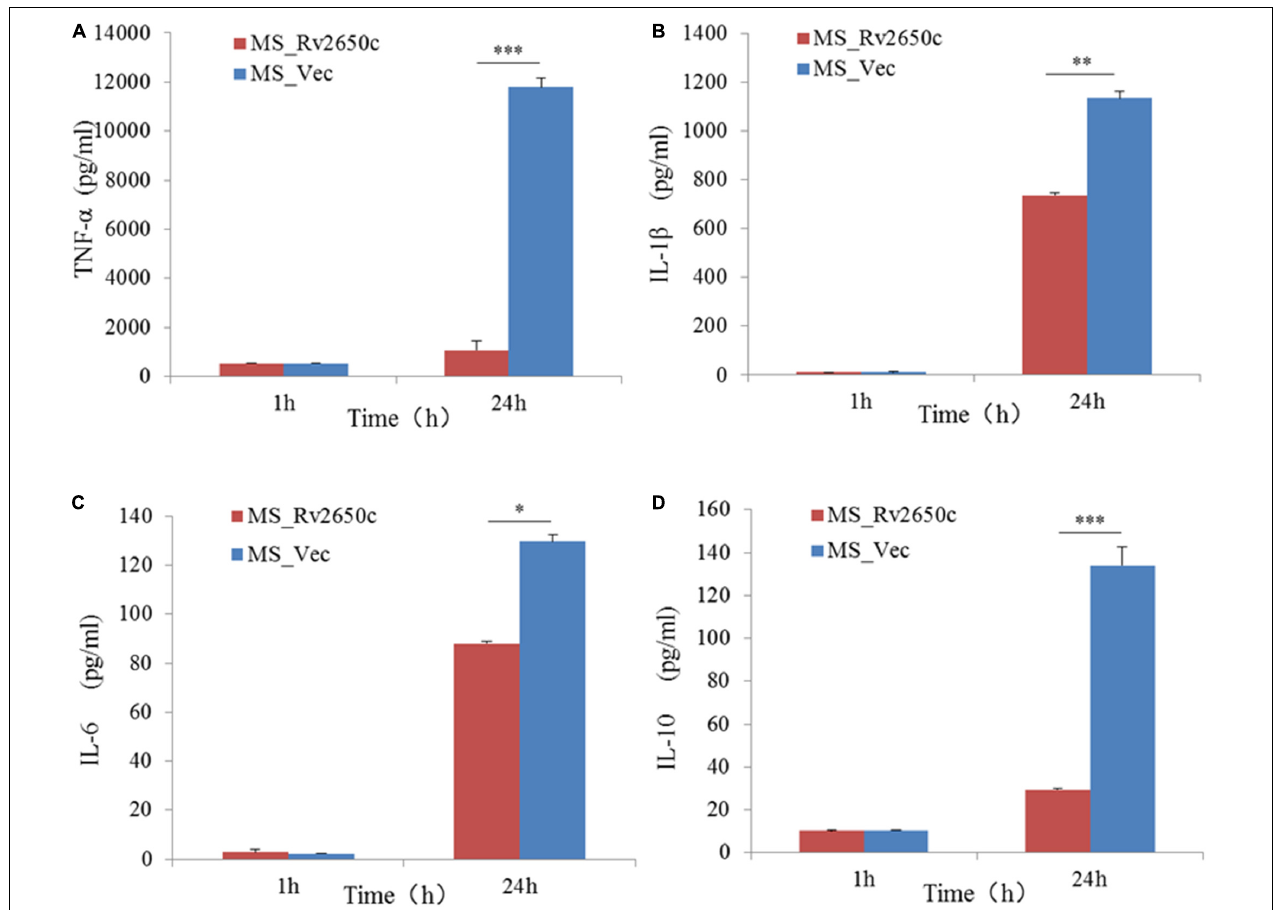
FIGURE 5 | Assay of secretion of cytokines in macrophages. The macrophages were infected with recombinant M. smegmatis MS_Rv2650c and MS_Vec at MOI 10:1, respectively, and the secretion of cytokines TNF- α , IL-10, 1L-1 β , and 1L-6 in macrophages was measured by ELSA. The supernatant at a certain time point was collected to detect the secretion of TNF- α (A) , 1L-1 β (B) , 1L-6 (C) , and IL-10 (D) . Similar results were obtained in 3 independent experiments. (* p < 0.05; ** p < 0.01; *** p <